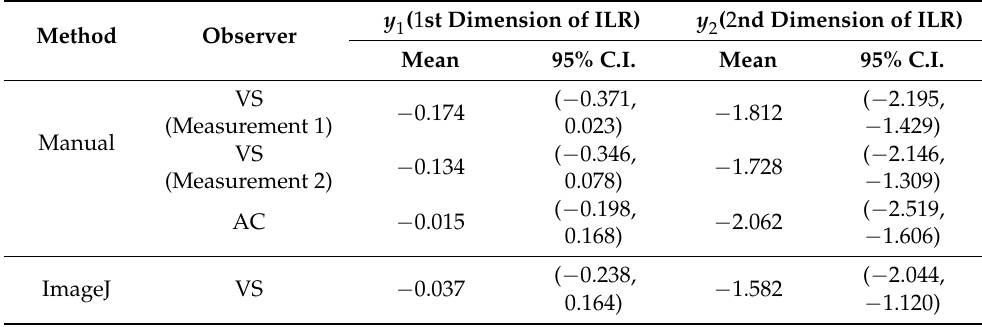
Table 2. Statistical tests for validation of the mixed-effects model assumptions.